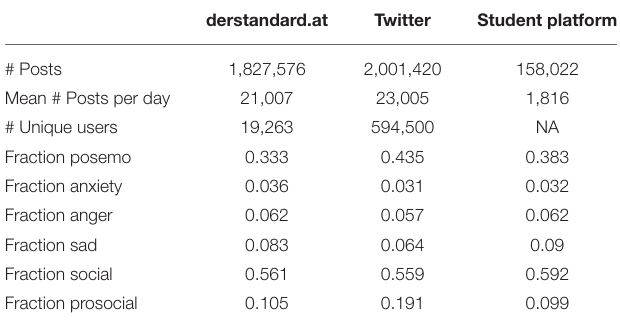
TABLE 1 | Descriptive statistics showing relevant aspects of the data sources.